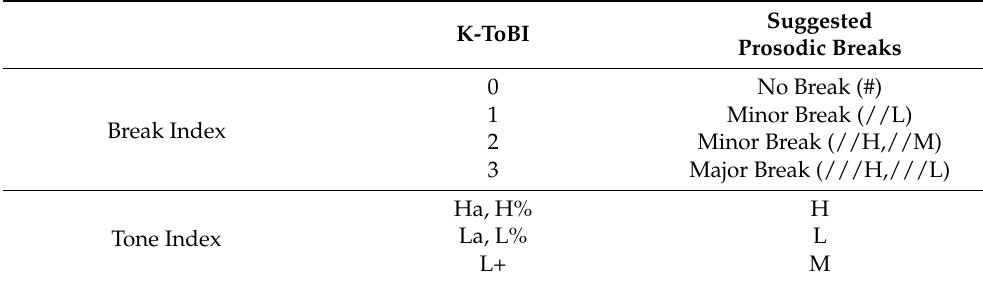
Table 2. Mapping between break indices of K-ToBI and the suggested prosodic breaks.